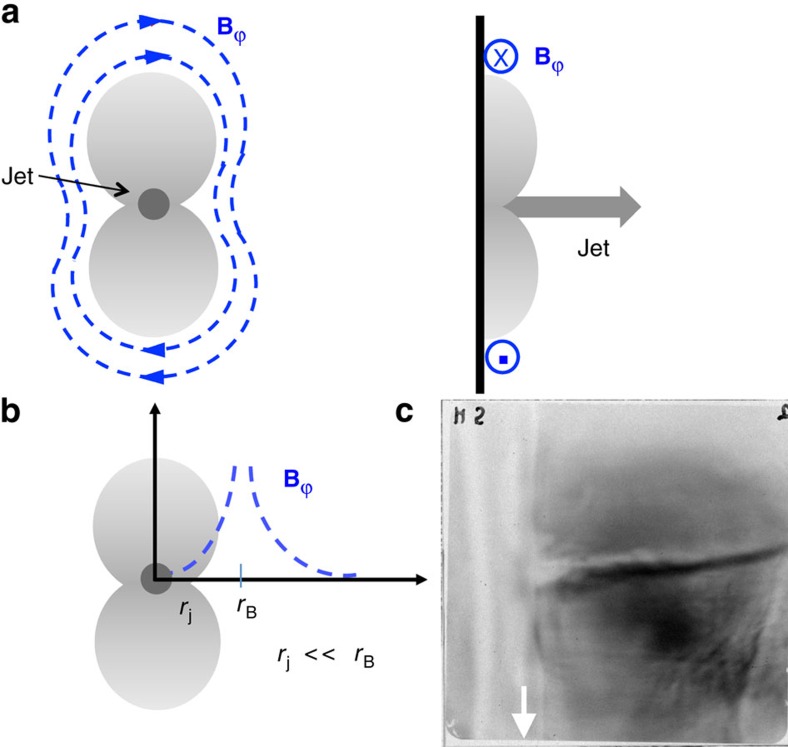
Plasma jet and magnetic field configurations generated by a laser-driven flat target.(a) Cartoons of face-on and side-on views of a plasma jet and associated toroidal magnetic fields after reconnection due to collision of two plasma plumes from a laser-driven plastic foil. (b) Radial distribution of magnetic fields indicate the toroidal components around the jet are too weak to excite the MHD instability (overwhelmed by the parallel components, that is, Bϕ/Bp<<1). (c) Proton side-on radiographic image shows the jet is stable to MHD instabilities when toroidal components are weak (white arrow points the position of flat foil target). It also suggests that in this type of experiment the toroidal fields generated by the plasma current are too weak to destabilize the jet propagation. The jet is predominately collimated by inertial confinement due to the hydrodynamic compression produced by the collision of the two plumes.